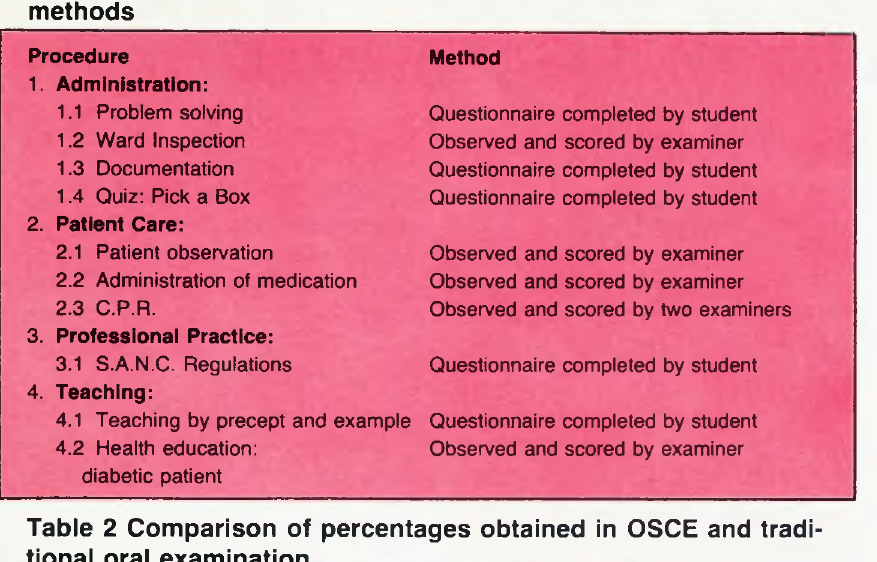
Table 2 Comparison of percentages obtained in OSCE and tradi­ tional oral